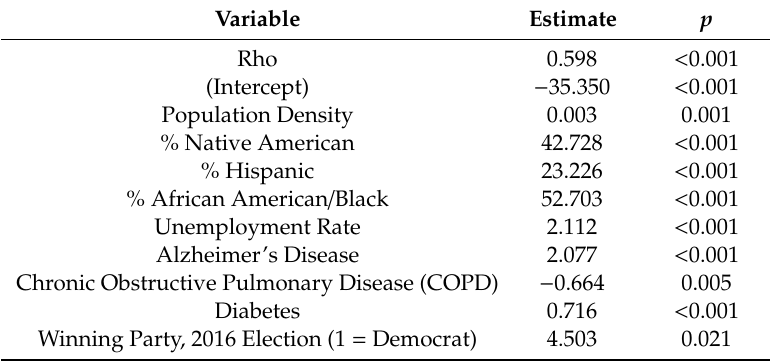
Table 5. Unscaled geospatial